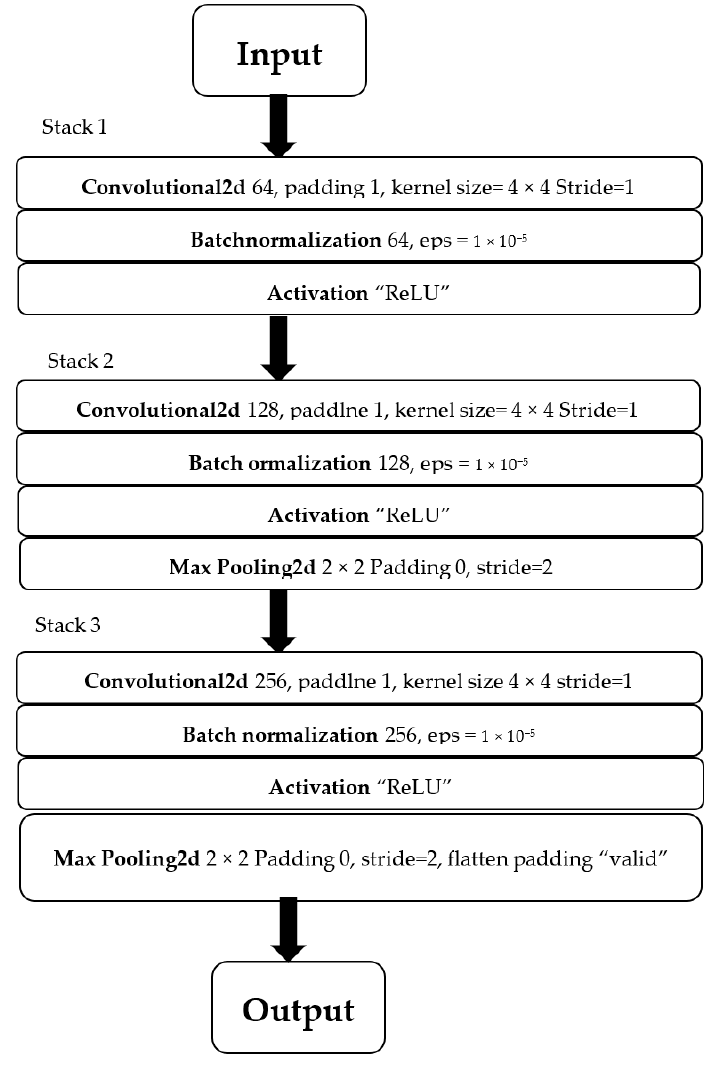
Figure 3. Proposed sequential deep neural network.